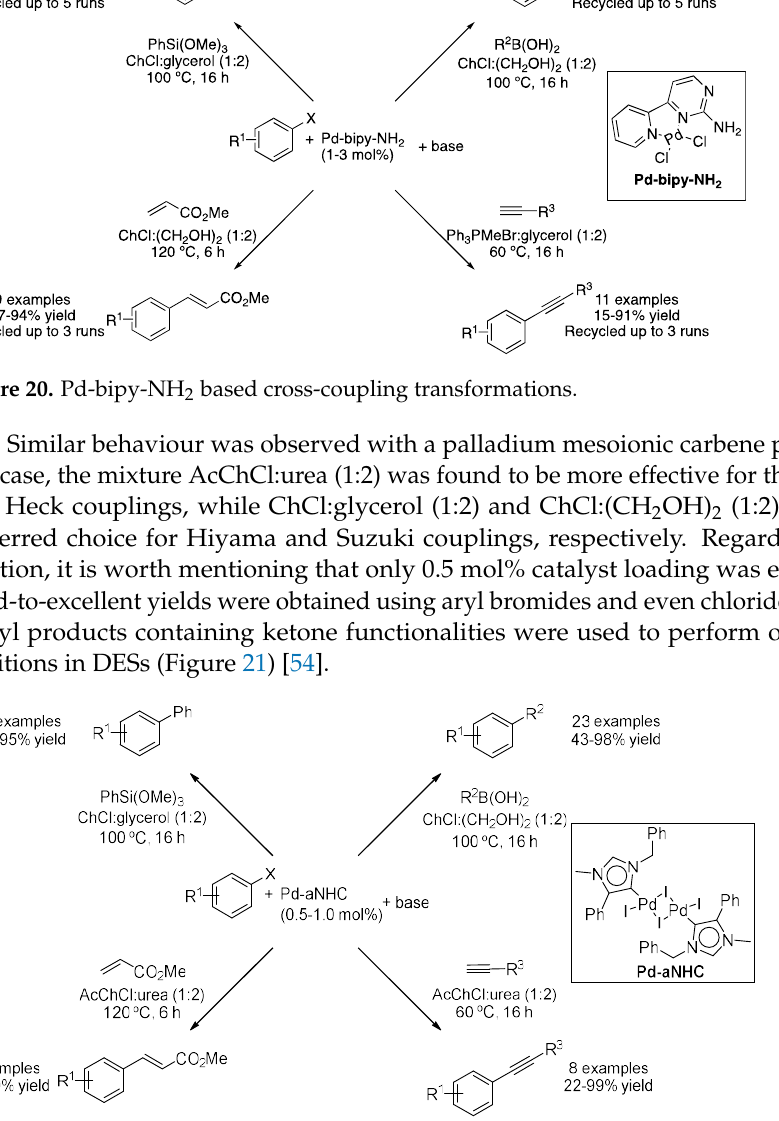
Figure 21. Pd-abnormal N -heterocyclic carbene catalyzed cross-coupling reactions.